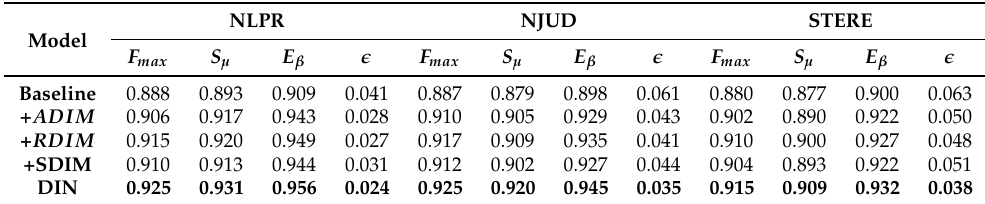
Figure 6. Visual effects of ablation studies. ( a ) Input image, ( b ) depth image, ( c ) ground truth, ( d ) baseline, ( e ) + ADIM , ( f ) + RDIM , ( g ) + SDIM , and ( h ) DIN. Table 3. Ablation studies in terms of F-measure, S-measure, E-measure, and MAE on NLPR , NJUD , and STERE